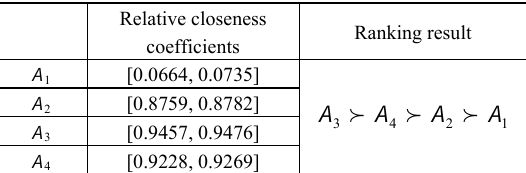
Table 5. Ranking result of strategic R&D projects using the weights generated for marketing